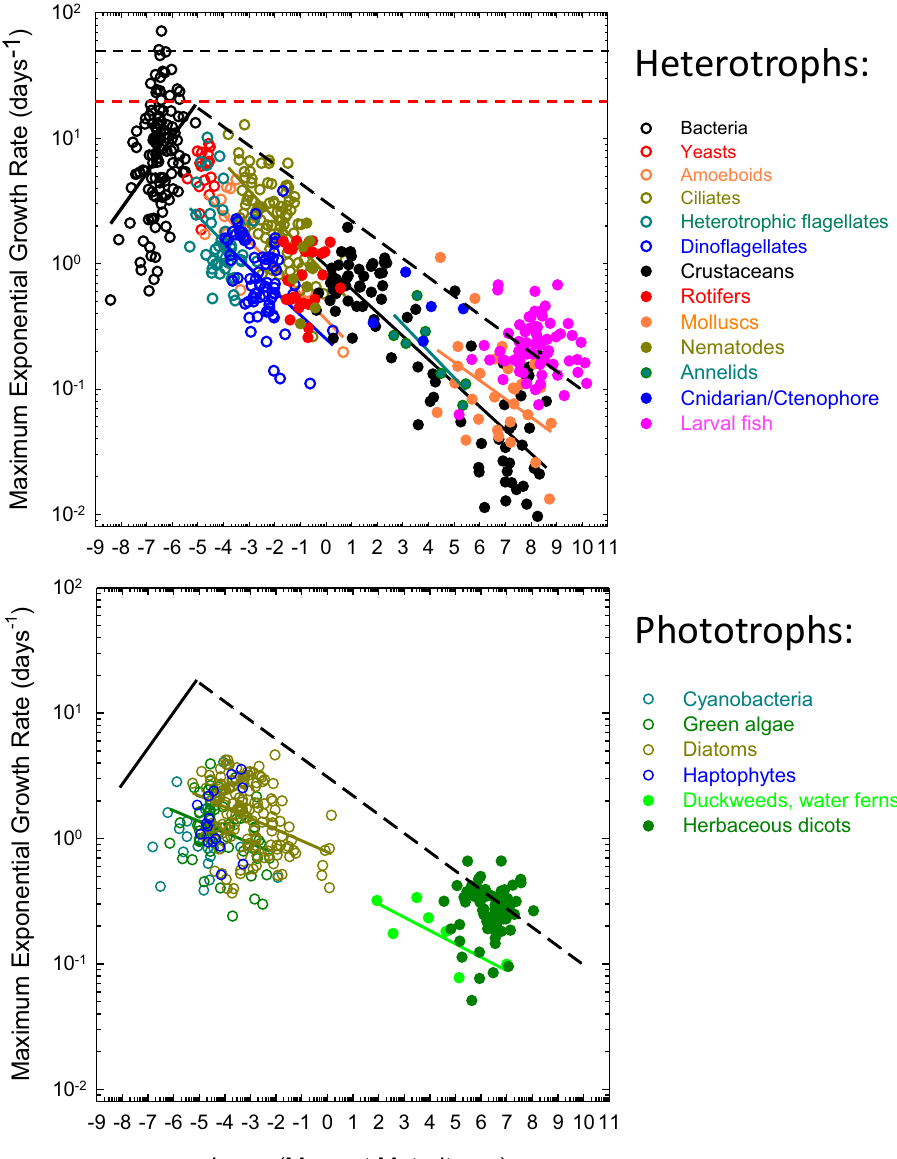
Figure 1. Relationship between estimates of maximum interval-specific growth rates and adult body mass for various taxonomic groups (normalized to 20 °C). Open points denote unicellular species; solid points multicellular species. The solid lines denote regressions (only shown for phylogenetic groups where significant), whereas the diagonal dashed line is the approximate upper bound to heterotrophic growth rates across all groups (as described in the text, and excluding larval fish). In the lower panel for autotrophs, the black lines from the profile for heterotrophs are added as reference points. The horizontal dashed black and red lines are the hypothetical upper bounds on growth rates dictated by the translational constraints imposed by the properties of ribosomes (as described in the